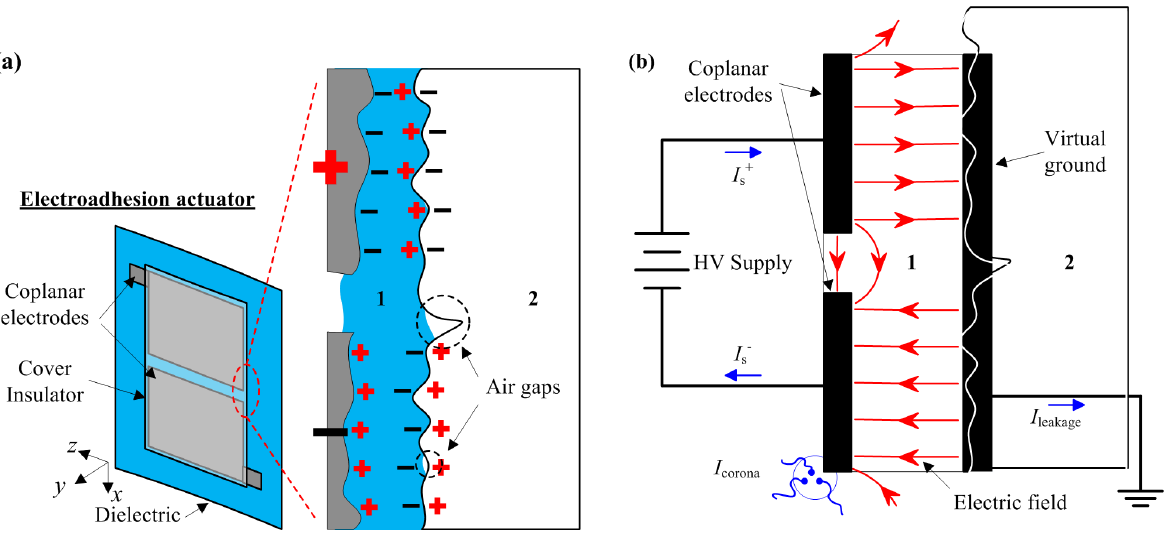
Figure 4. Applying HV to the electroadhesion actuator while placing it on the test surface. ( a ) The induced charge as a result of polarization in dielectric Material 1; ( b ) the electrical schematic and the E field